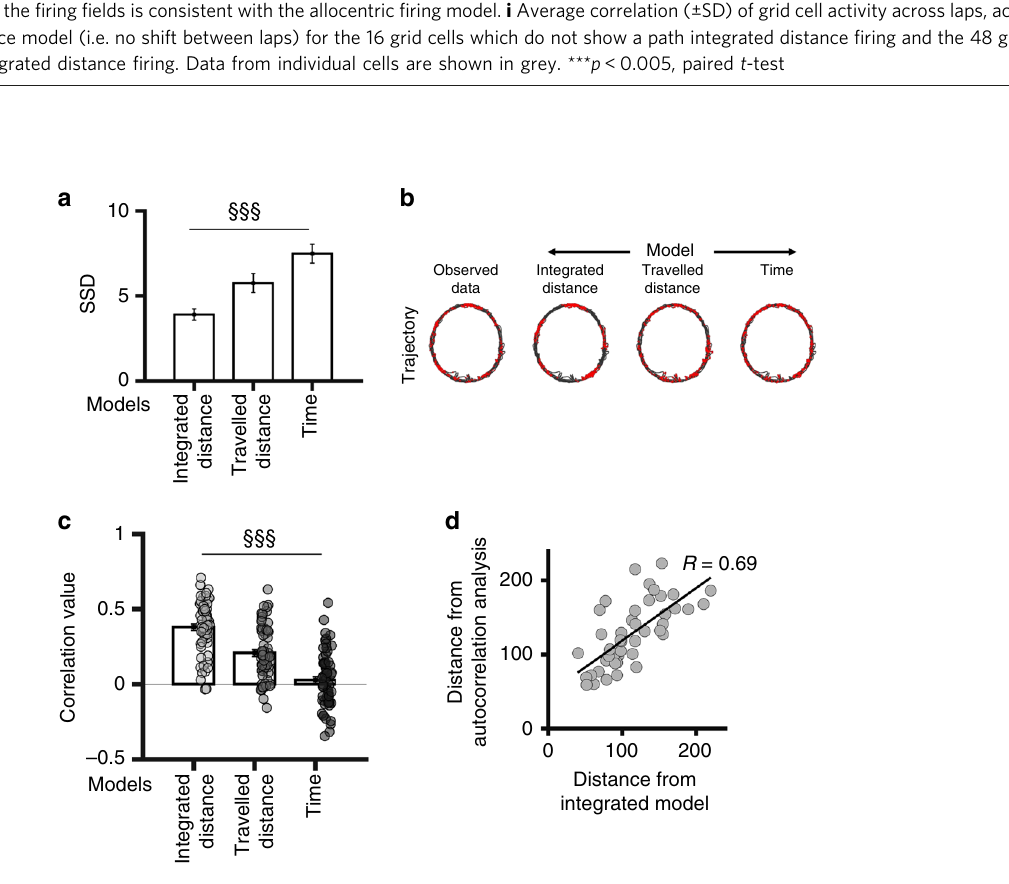
Fig. 4 Grid cell regularity is based on path integrated distance-model fi tting. a Average value (±SEM) of the fi tting score (i.e. the sum of squared differences of the best fi tting) for the path integrated distance, travelled distance and time model. §§§ p < 0.001, repeated measure ANOVA. b Activity of one grid cell in the track from the real data (left) and reconstructed with best- fi t parameters for each model (right ‘ MODEL ’ ). Real (left) or reconstructed (right ‘ MODEL ’ ) trajectory of the animal with spike locations. c Average spatial correlation (±SEM) between the reconstructed maps from each model and the observed maps. Dots represent values from individual grid cells. §§§ p < 0.001, repeated measure ANOVA. d Scatterplot showing the relation between the distance (i.e. path integrated distance) calculated with two different methods (i.e. autocorrelations and model fi tting); the Pearson correlation coef fi cient ‘ R ’ is indicated (Fig. 5d; one-way ANOVA: F 2129 = 44.34, p < 0.001, Tukey HSD between all environments (Supplementary Figure 5e-g; large arena post hoc, large arena/small arena vs large arena/large track: p < vs small arena: correlation coef fi cient = 0.71, p < 0.001; large arena 0.001, large arena/small arena vs large arena/small track: vs large track: correlation coef fi cient = 0.48, p < 0.001; large track vs p < 0.001, large arena/small track vs large track/large small: p < small track: correlation coef fi cient = 0.53, p < 0.005), indicating the 0.001). These results indicate that both the shape of the maintenance of an internal coherence within the grid cell system environment and its size profoundly in fl uence grid cell metrics. across environments. A difference in the tactile input between the small and the large Altogether, our results demonstrate that in a continuous one- track (due to changes in the curvature of the walls) could potentially dimensional track, grid cell fi ring is in fl uenced by a combination contribute to this process 27,28 . Next, we investigated whether the of dynamic idiothetic cues and static allocentric cues. changes in fi eld spacing were coherent across different environ- ments (e.g. grid cells with a small fi eld spacing in the arenas yielded also small fi ring distances in the tracks according to the integrated MEC theta rhythm may underlie grid cell metrics changes . LFP distance model). We found that fi eld spacing was correlated signals play a critical role in grid cell generation. In particular,